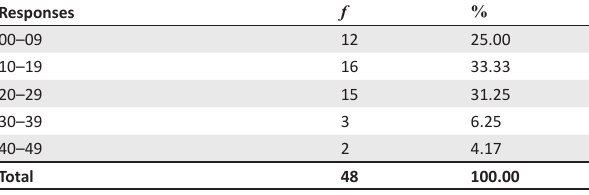
FIGURE 1: Representation of respondents’ professional qualifications ( n = 53). TABLE 1: Respondents’ years of experience ( n = 48). Responses